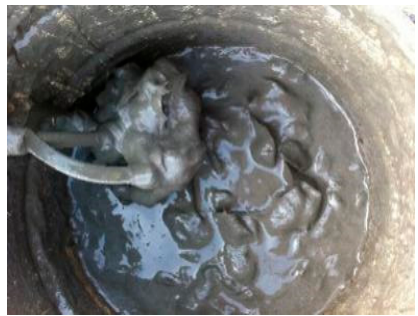
Figure 2. Cement paste mixed basalt fiber directly.